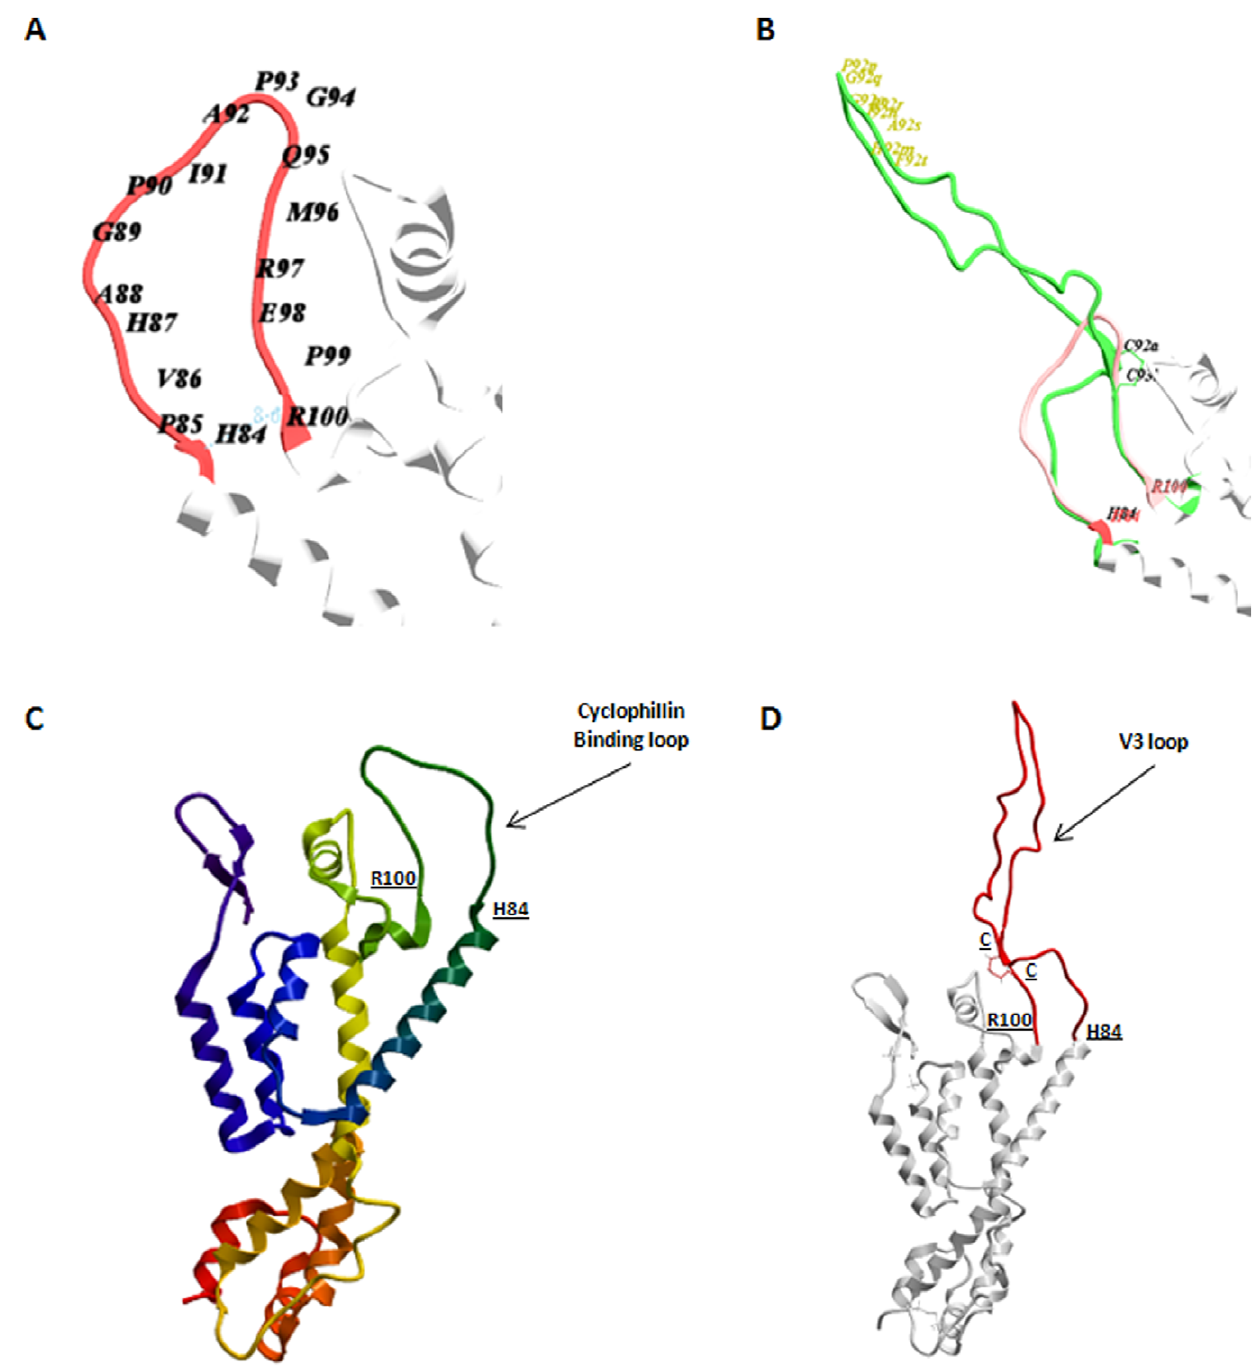
Figure 1. Identification of acceptor site in the p24 CA protein. The cyclophillin binding loop on the p24 CA protein is identified between the boundary residues H84 and R100 (PDB accession code 3GV2) ( A ). The full V3 loop sequence (green) as observed in the gp120 X-ray structure (PDB accession code 2B4C) has been introduced between the H84 and R100 residues and superimposed to the cyclophillin binding loop (red). Side view ( B ). The cysteins at the base of the V3 loop as well as the sequence at the tip of the V3 loop are indicated. The overall wild type ( C ) and chimeric ( D ) p24 structures are shown.